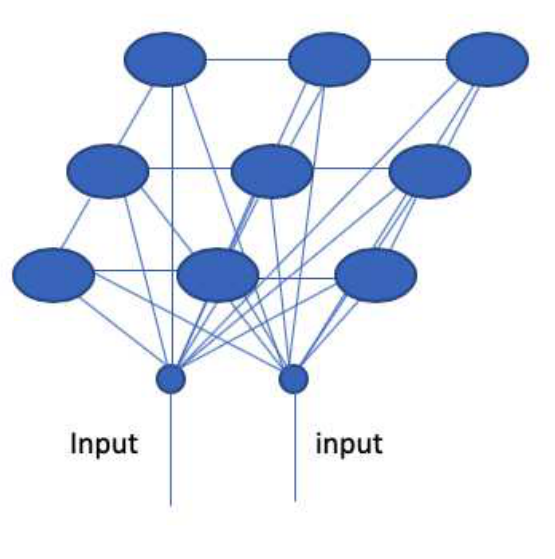
Figure 3. Kohonen